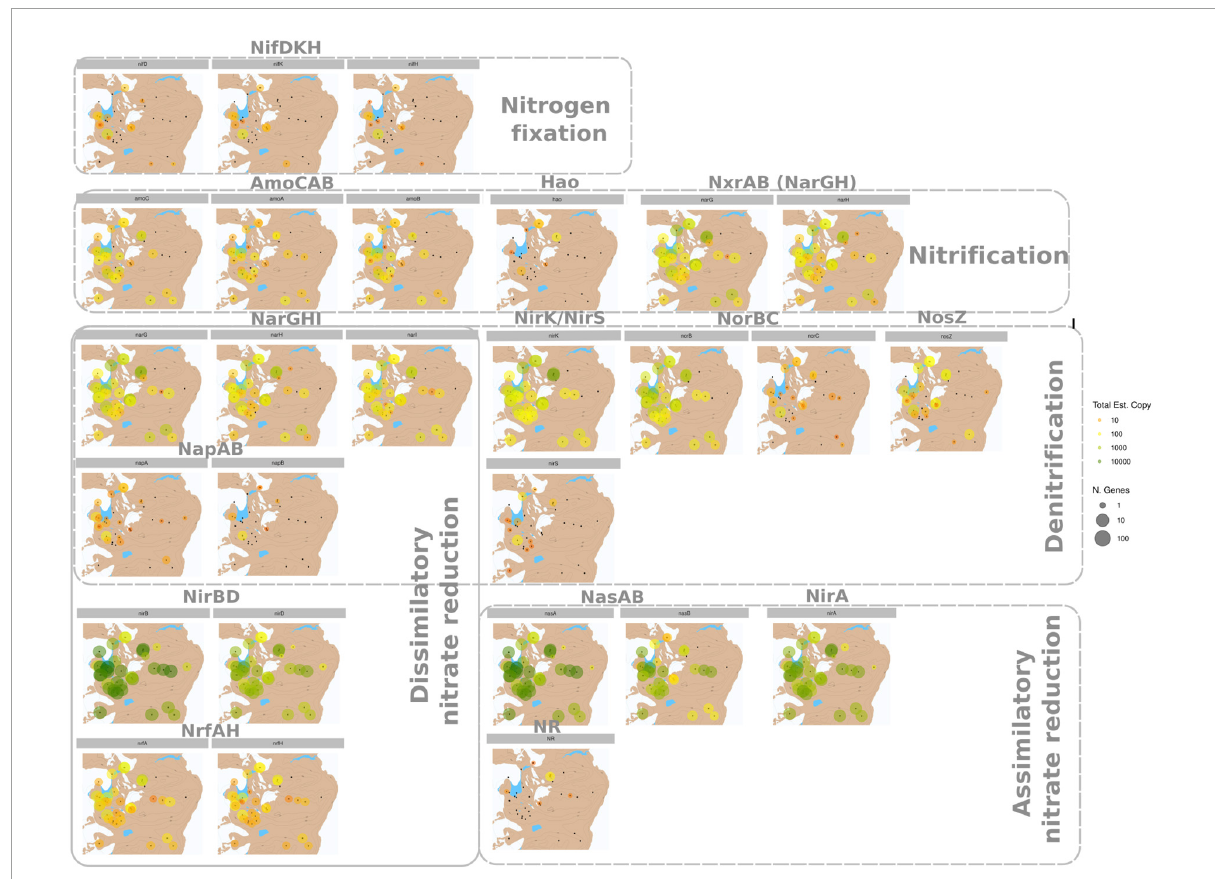
FIGURE4 Mapping of gene abundance and richness grouped by pathway and ordered by protein and reaction order. For each of the analyzed genes from Table 1 that were identified the total estimated copy number (which indicates gene abundance) is illustrated with a color gradient from orange (lowest) to green (highest); The number of genes is illustrated with the size of the site-points, from lowest number of genes to highest number of genes and indicate gene